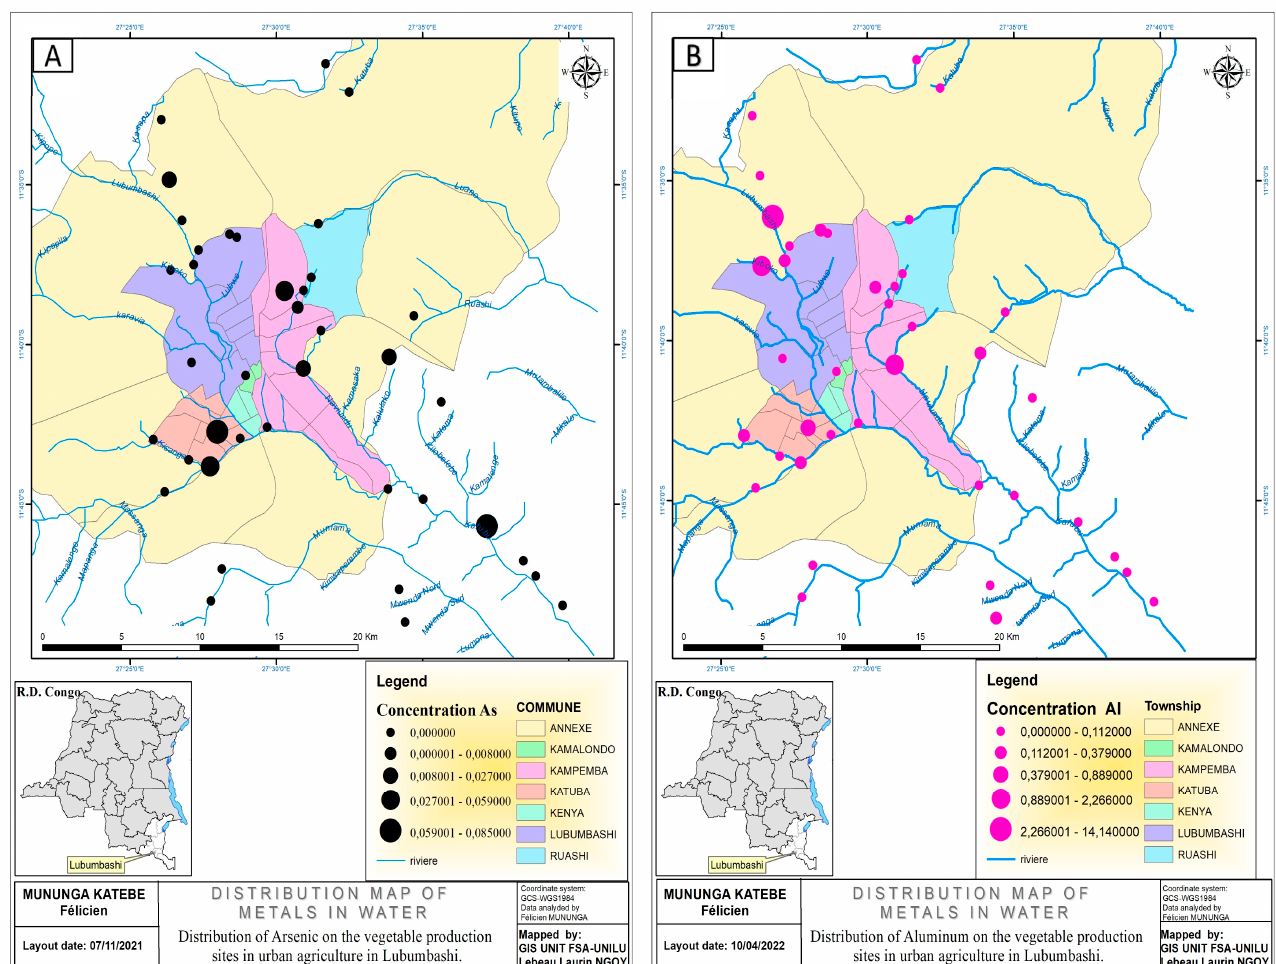
Figure 11. Spatial distribution of metals (As and Al) in the waters of Lubumbashi market gardens (A and B).